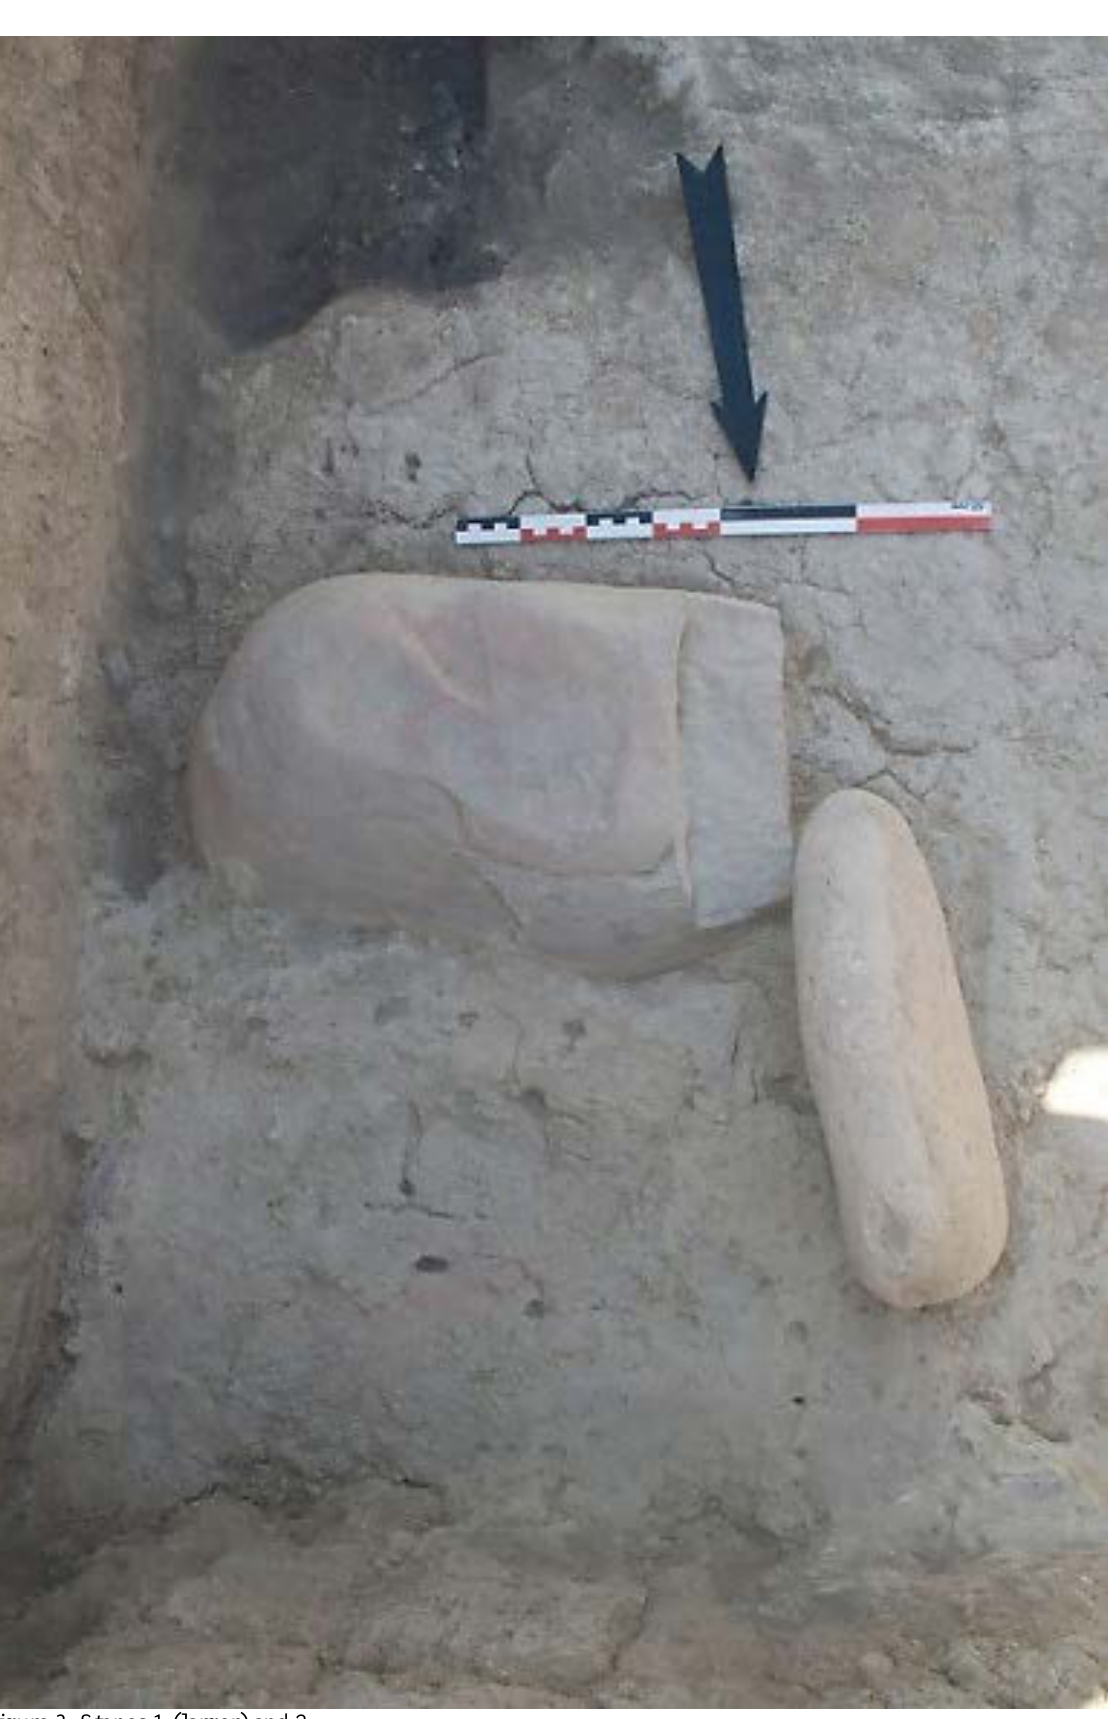
Figure 3. Stones 1 (larger) and